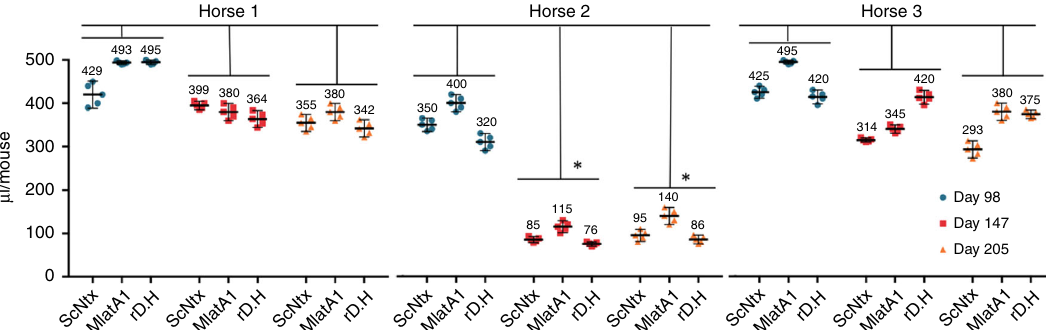
Fig. 2 Neutralization potencies, plotted as median effective dose (ED 50 ). Serum samples were obtained from individual horses immunized with the consensus short-chain α -neurotoxin (ScNtx) at days 98, 147, and 205. ED 50 values are expressed in µ L/mouse (volume of anti-ScNtx able to neutralize 3 × LD 50 (lethal dose, 50%) of puri fi ed short-chain neurotoxins ScNtx, MlatA1 or rD.H.). Values were estimated in groups of fi ve mice, injected by the intravenous route. Error bars represent the 95% con fi dence limits for the ED 50 value. The data obtained from the groups of “ Horse ” and “ Day ” of immunization were analyzed statistically by two-way analysis of variance (ANOVA) followed by paired Student ’ s t test. A p value of <0.05 was considered signi fi cant, as indicated by *. Horse 2 produces antibodies with the best neutralization potencies from after the 147th day of immunization